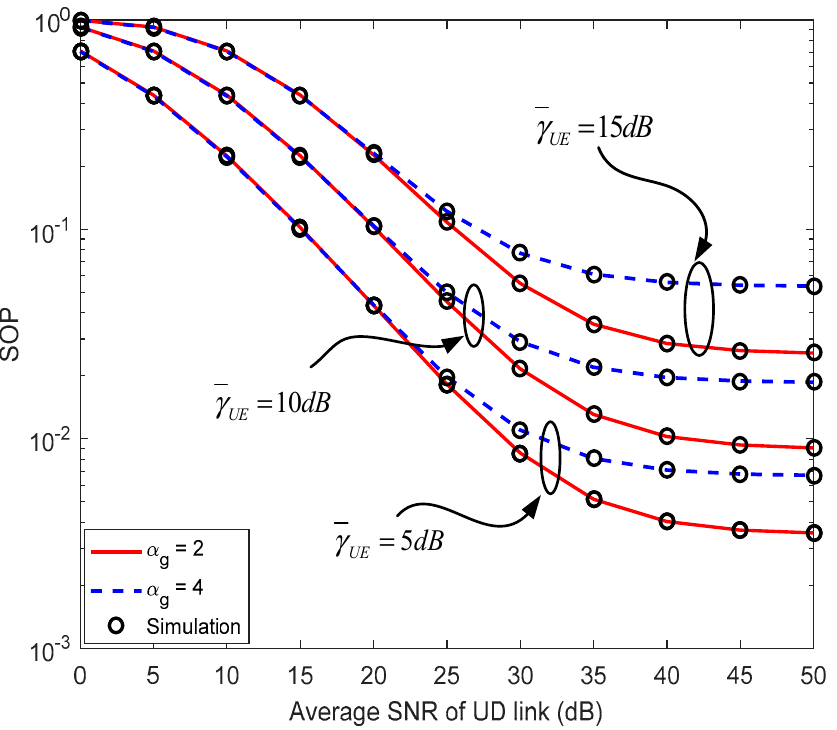
Figure 5. The influence of average SNR at eavesdroppers and path loss factor on the network SOP under γ BU = 35 dB and h u = 1 km.